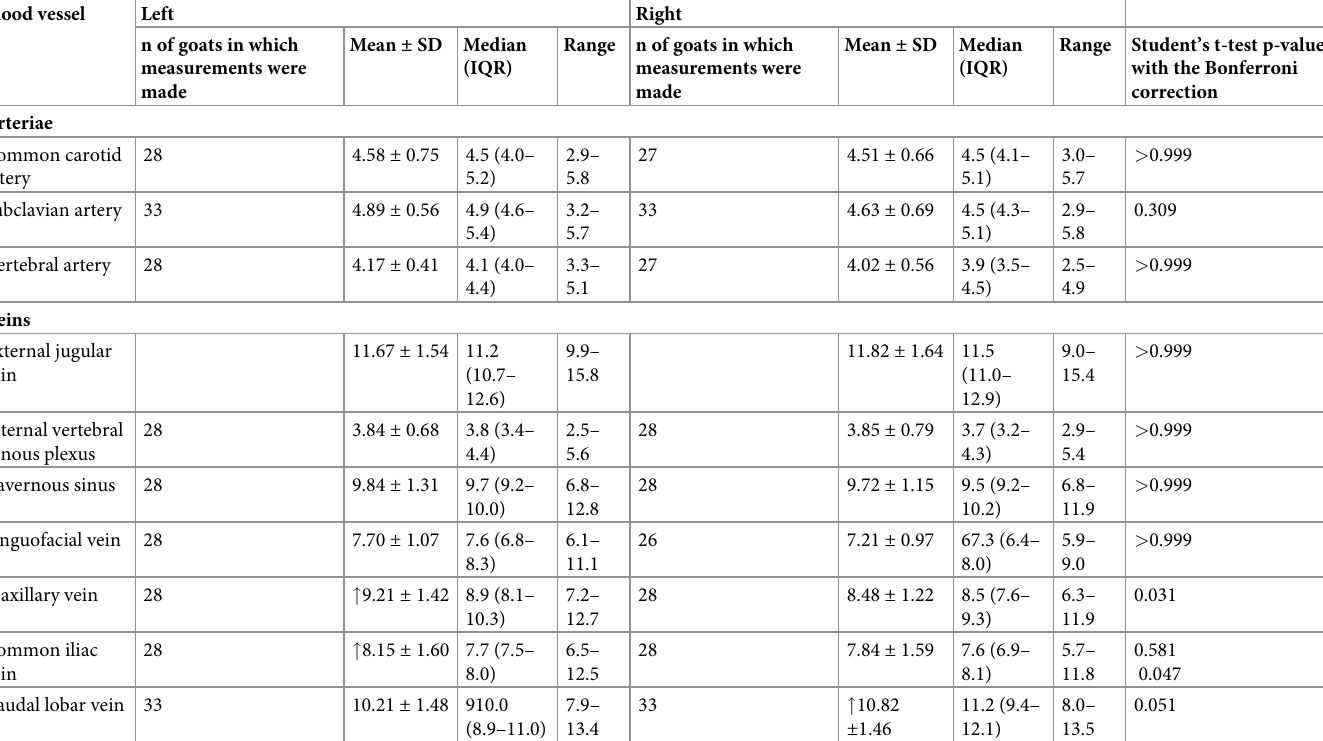
Table 1. Descriptive statistics of paired blood vessels measurements (in mm) compared between sides using paired Student’s t-test with the Bonferroni correction of p-value ( α = 0.05). " indicates significant difference.